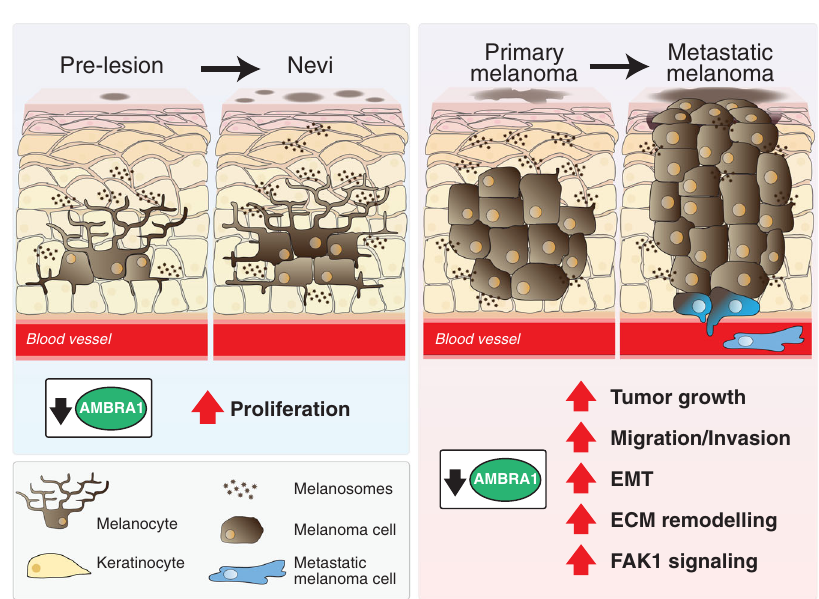
Fig. 7 Ambra1 impacts on melanoma development. Ambra1 de fi ciency increases the formation of nevi by affecting melanocytes proliferation in Braf V600E mutated mice. When melanoma is induced upon Braf V600E and Pten ablation, the absence of Ambra1 promotes tumor growth and metastasis by increasing cell migration and invasion, activating the EMT process, remodeling the ECM and triggering the FAK1 signaling